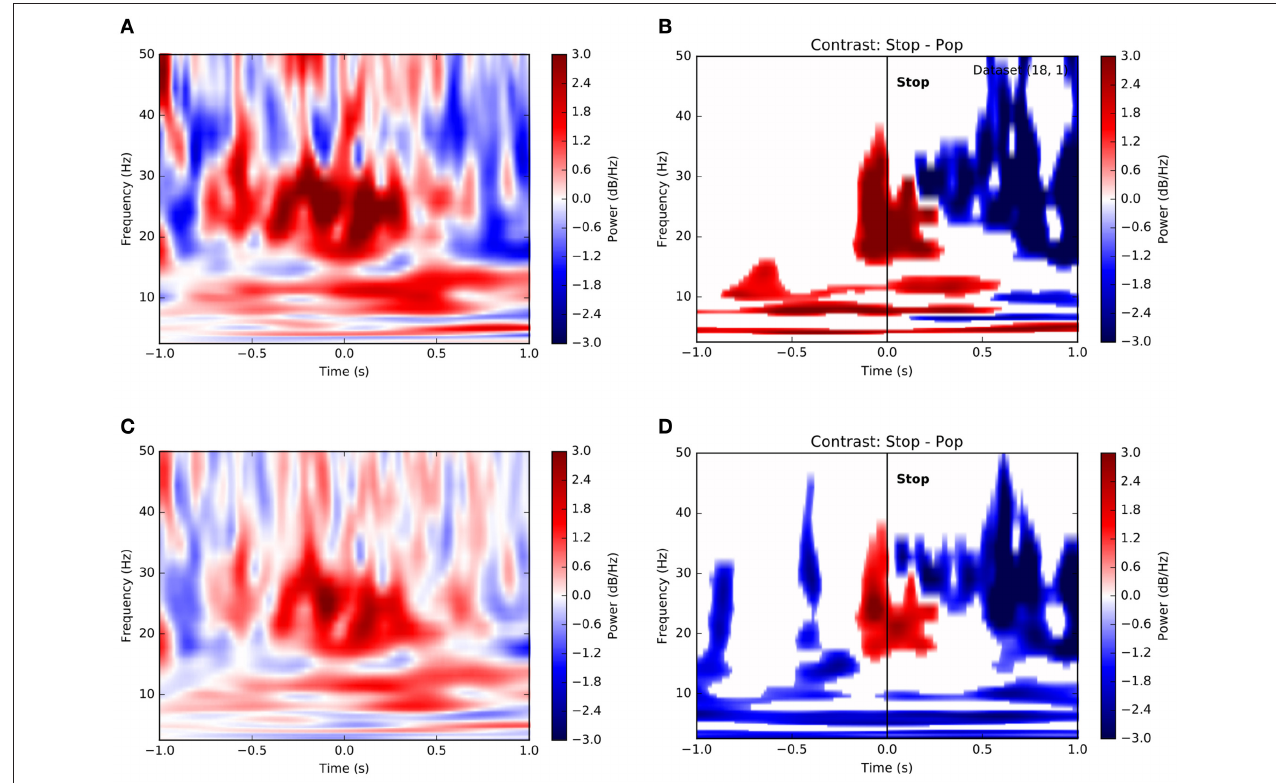
FIGURE 4 | Time-frequency contrasts show dissociable roles for different frequency bands in stopping. (A) Time-frequency plot of power on successful stop trials aligned to time of stop ( t = 0) for a single subject. Color depicts change normalized change in power relative to pre-trial baseline in decibels (see Methods). Increases in both low-frequency power and beta band activity precede the stop. (B) Significance-thresholded time-frequency contrast plot depicting differences in power between successful and unsuccessful stop (pop) trials for a single subject. Conventions and subject are as in (A) . Clusters represent statistically significant changes in activity between conditions (see Methods). Here again, voluntary stop decisions are marked by early increases in low-frequency power and peri-stop increases in beta band power more proximal to movement. (C) Equivalent of (A) using all trials across all subjects. (D) Equivalent of (B) using all trials across all